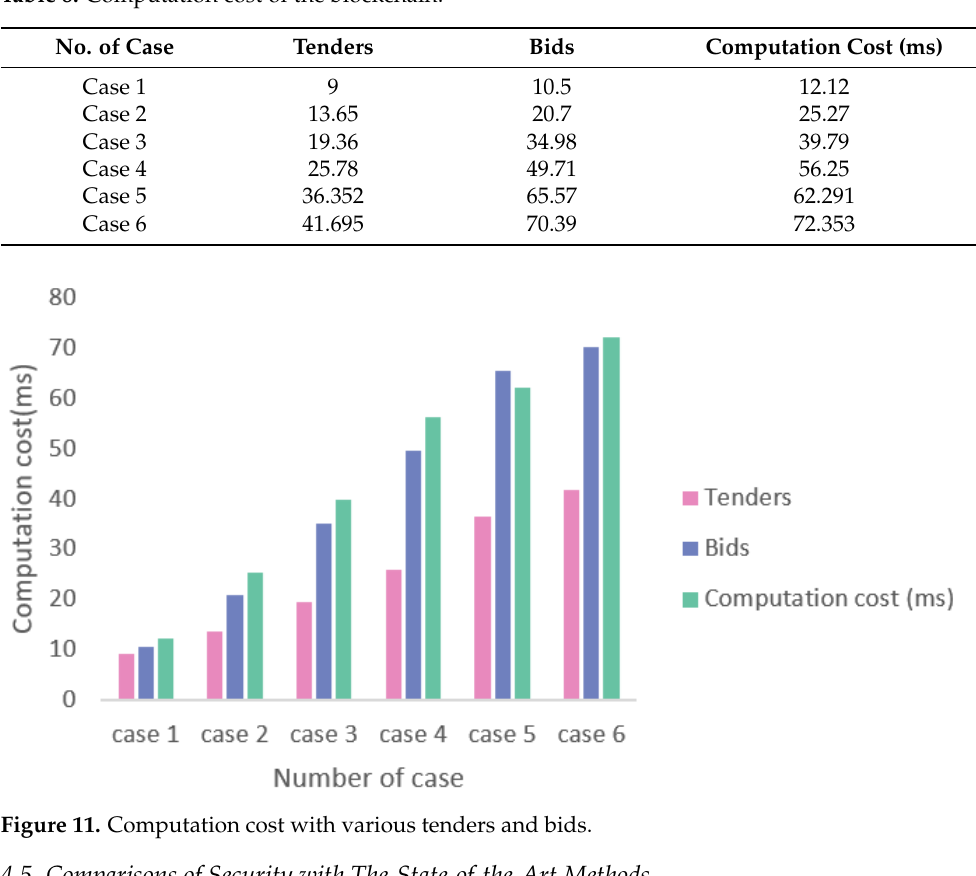
Table 8. Computation cost of the blockchain.